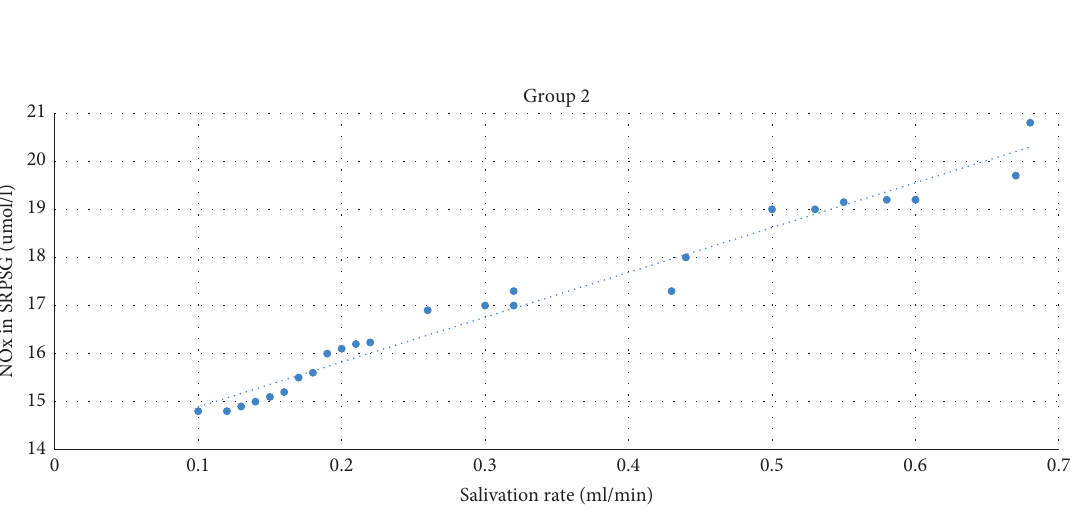
Figure 5: The correlation between the NOx level in SRPSG and the salivation rate among patients in Group